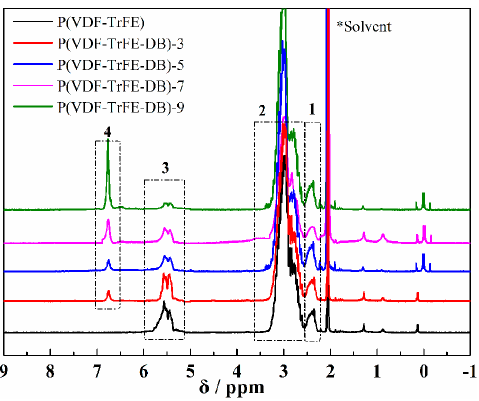
Figure 1. Typical 1 H NMR spectra of P(VDF-TrFE) (80/20 mol %) and P(VDF-TrFE-DB)s with increased double bonds from 3 mol % to 9 mol %.